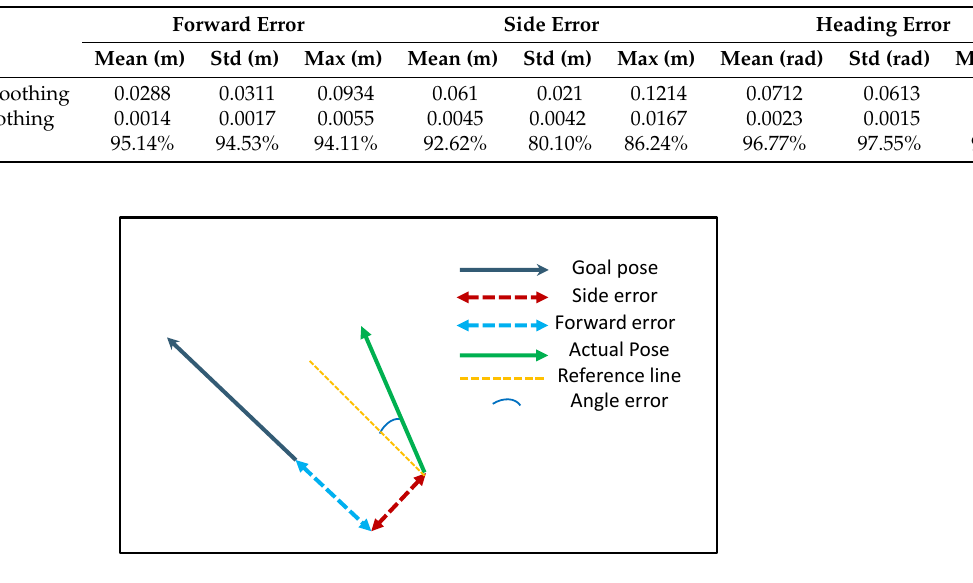
Figure 10. Error decomposition diagram, including side, forward, and heading errors, used to evaluate the